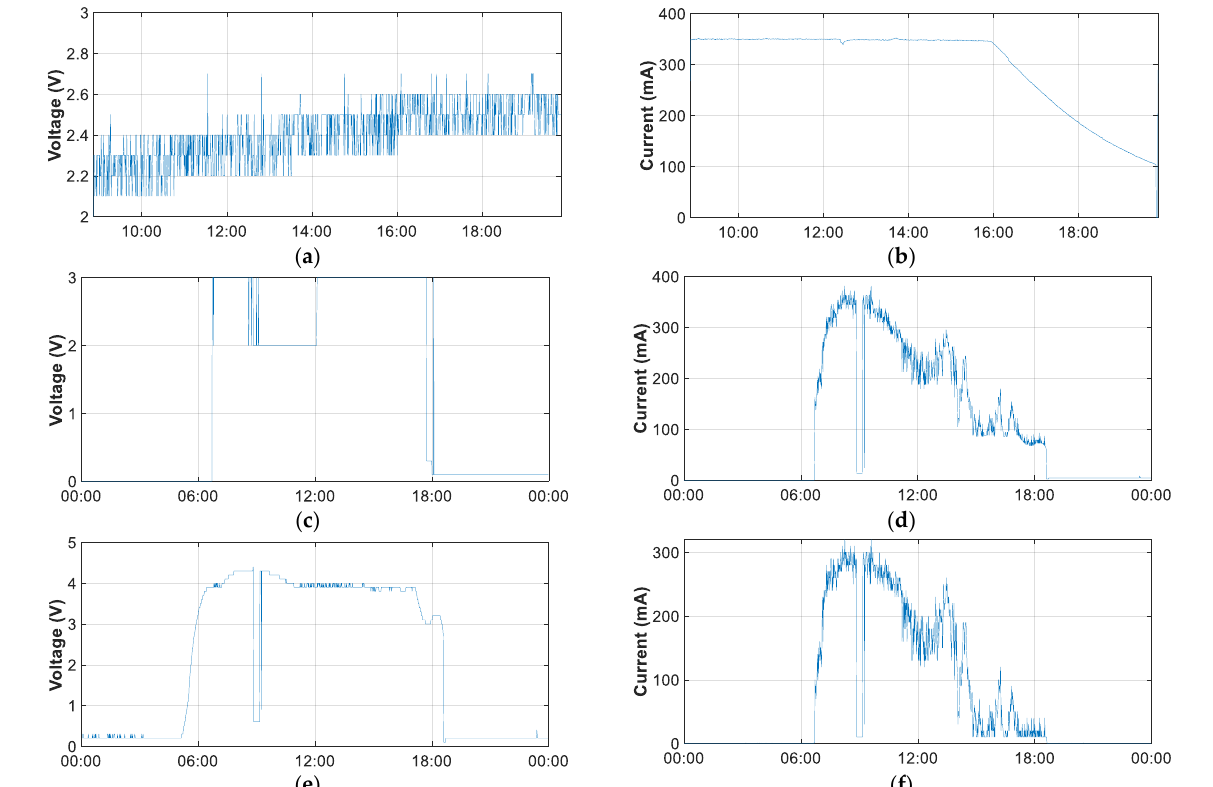
Figure 21. Electrical variables measurement in battery charge: ( a ) battery voltage in USB charge; ( b ) battery current in USB charge; (c) battery voltage in PV charge; ( d ) battery current in PV charge ( e ) PV voltage in PV charge; and ( f ) PV current in PV charge.